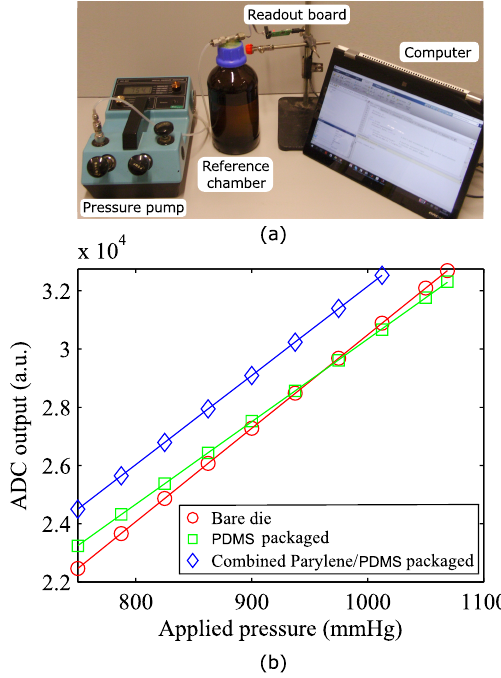
Figure 6. ( a ) Calibration setup; ( b ) plot of the ADC registered value as a function of the absolute applied pressure for: the bare die (red, circle), the PDMS-packaged (green, square) and combined parylene/PDMS-packaged sensor (blue,